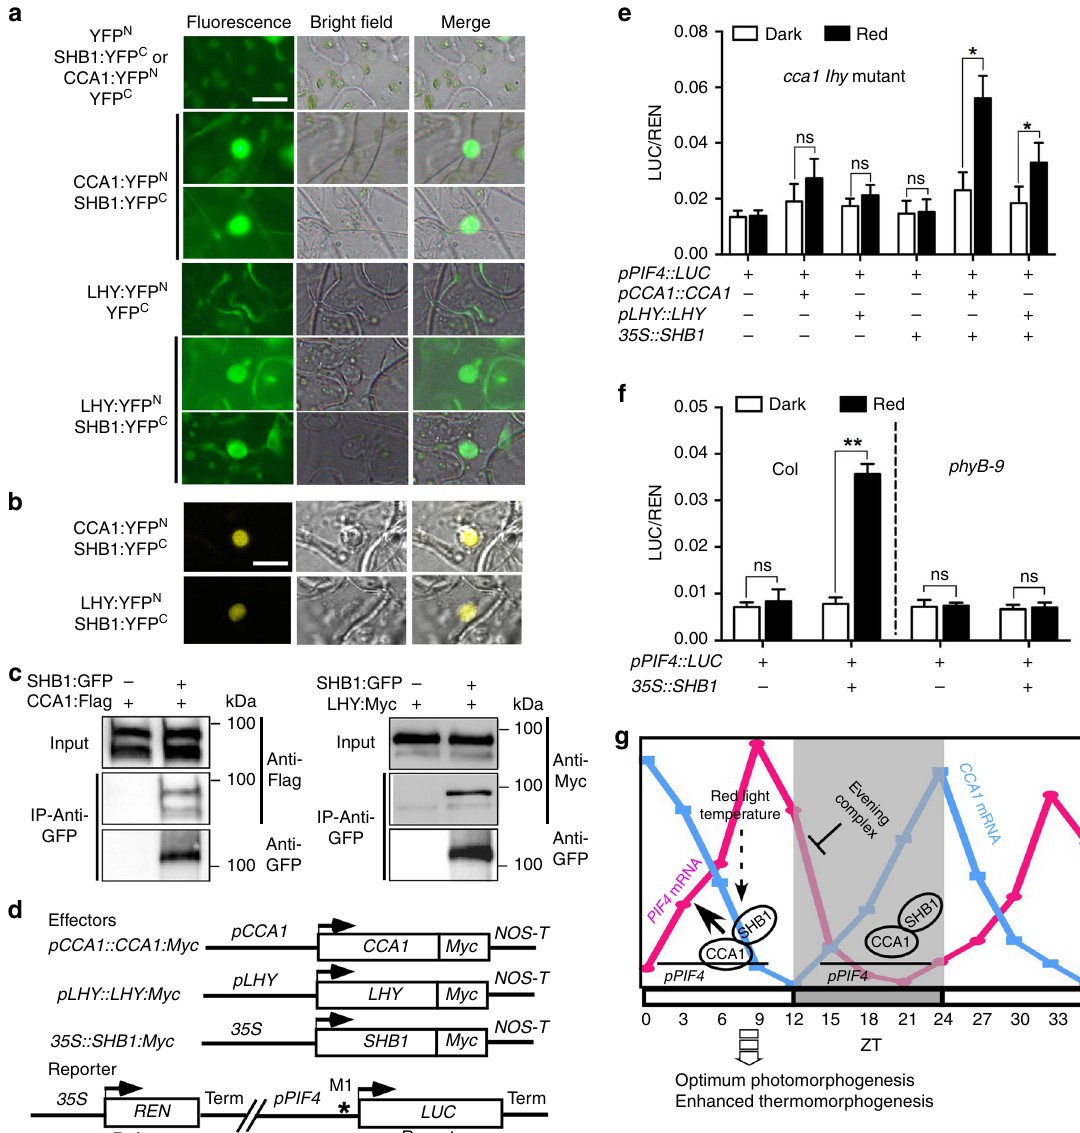
Fig. 6 SHB1 co-acts with CCA1 and LHY. a BiFC fl uorescent images of YFP N with SHB1:YFP C , CCA1:YFP N or LHY:YFP N with YFP C , and CCA1:YFP N or LHY: YFP N with SHB1:YFP C . b BiFC confocal images of CCA1:YFP N or LHY:YFP N with SHB1:YFP C . Images were captured 48 – 72 h in Nicotiana leaf epidermal cells after Agrobacteria transfection. Bar = 10 μ m. c Co-immunoprecipitation (Co-IP) of CCA1:FLAG or LHY:MYC by SHB1:GFP in protein extracts prepared from transgenic Arabidopsis with anti-GFP antibody. d Effector, reporter, and reference constructs used. Arrowheads indicate transcription start sites, and NOS-T represents polyadenylation signal from the nopaline synthase gene. Asterisk indicates the location of the M1 element in the PIF4 promoter. Relative LUC/ REN activity in cca1 lhy transformed with a reporter along with pCCA1::CCA1:MYC , pLHY::LHY:MYC or 35 S::SHB1:MYC e and in Col or phyB-9 transformed with reporter in the absence or presence of 35 S::SHB1:MYC f in the dark or under red light. Source data are provided as a Source Data fi le. g A model explaining the regulation of CCA1 or LHY and SHB1 over PIF4 expression. PIF4 expression is repressed by the evening complex (EC) or PRRs at early evening. Toward the end of night and after dawn, CCA1 recruits SHB1 to mediate red light induction of PIF4 expression. This constitutes a signaling loop to optimize photomorphogenesis and enhance